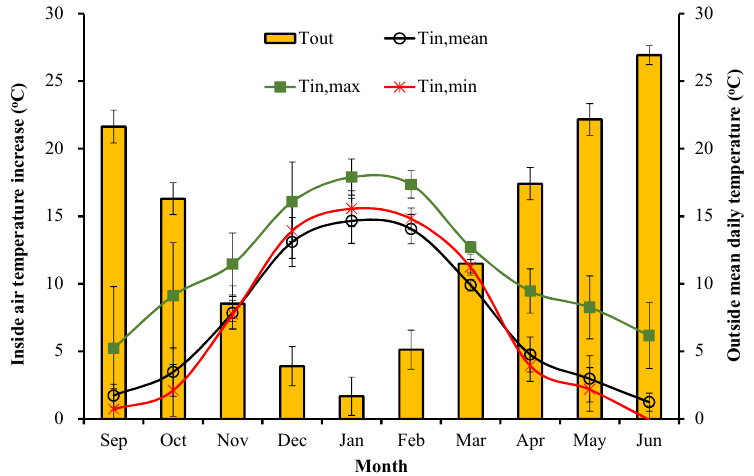
Figure 4. The increase in daily maximum (Tin,max), minimum (Tin,min), and mean (Tin,mean) air temperatures inside and the daily mean temperatures (Tout) outside the sunken solar greenhouse averaged over each month in the seven seasons. Data in July and August are excluded because the greenhouse undergoes high-temperature soil sterilization.